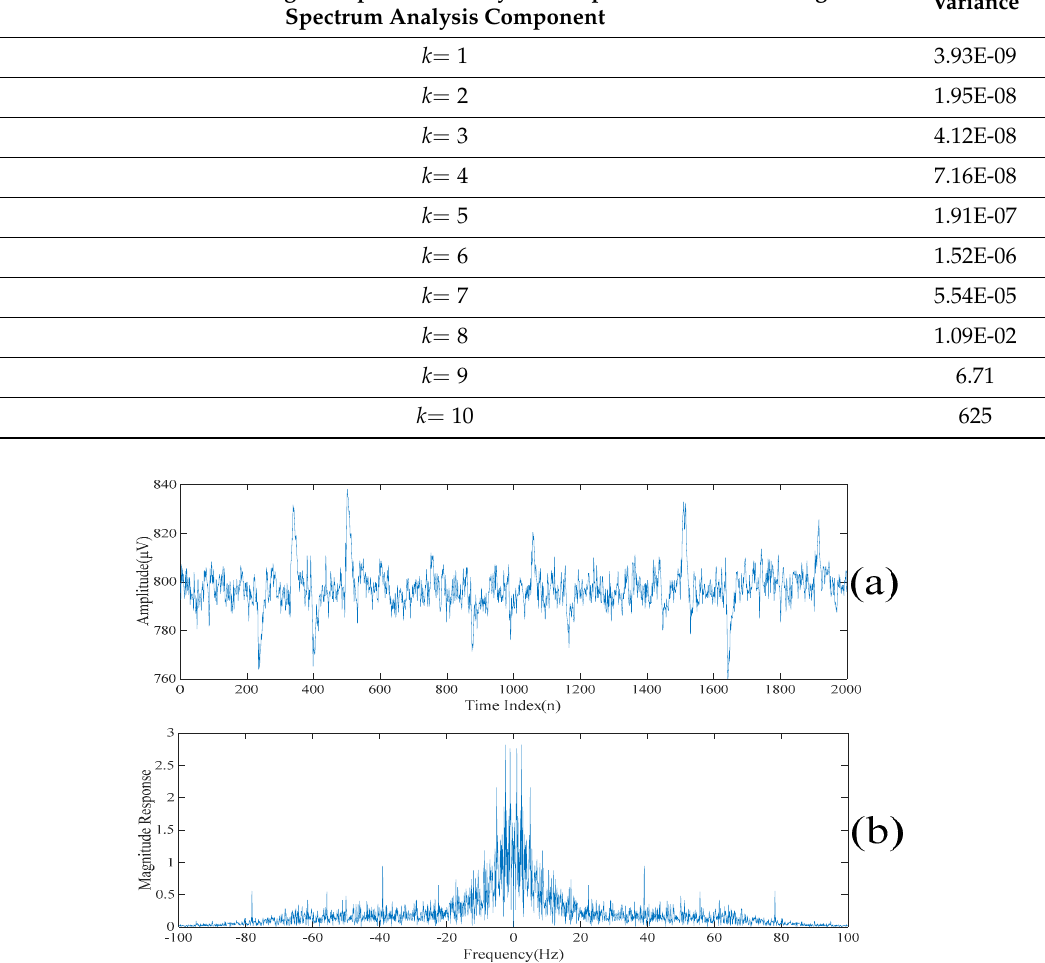
Figure 2. ( a ) A realization of a section of an acquired electroencephalogram in the time domain. ( b ) A realization of a section of an acquired electroencephalogram in the frequency domain.